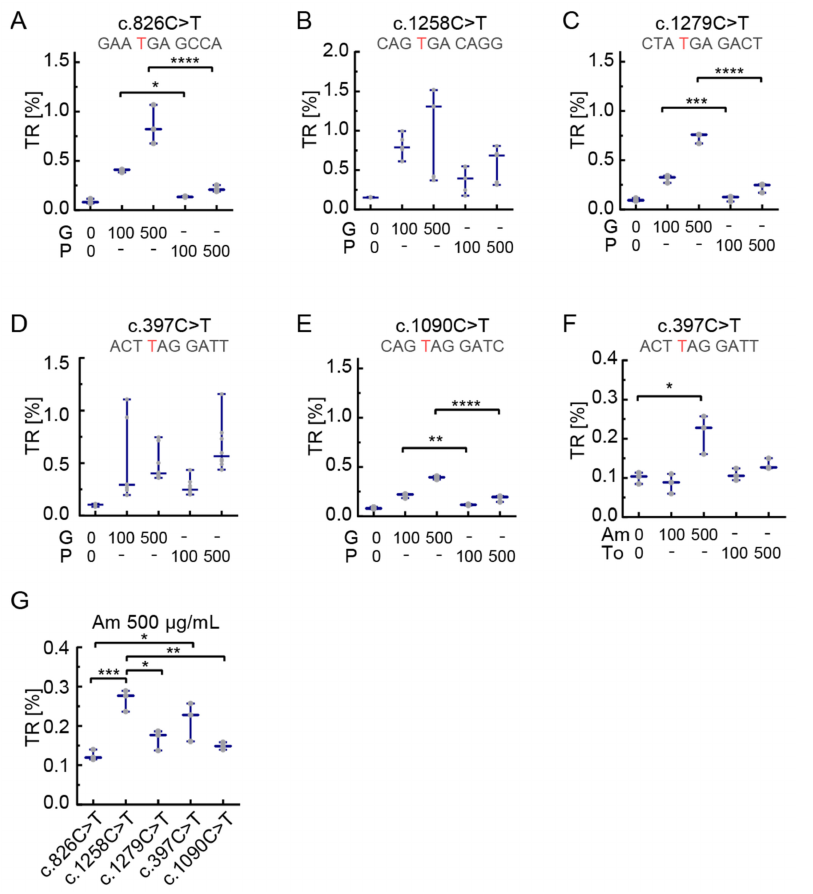
Figure 3. SCC-dependent translational readthrough induction by aminoglycosides. TR induction of gentamicin (G) and paromomycin (P) was analyzed at concentrations of 100 and 500 µ g/mL. ( A – C , E ) Gentamicin leads to higher TR (ns for B) induction than paromomycin in all tested SCCs except c.397C>T. ( D ) In contrast to the other SCCs, paromomycin induces similar TR at c.397C>T as gentamicin. ( F ) Amikacin (Am) at 500 µ g/mL induced significant TR (about 0.25%), while tobramycin (To) did not induce significant levels of TR. ( G ) At 500 µ g/mL, Amikacin induced TR best in c.1258C>T and the c.397C>T SCC. These levels were significantly higher than for the other three SCC. N = 5 ( A , D ); N = 3 ( B , C , E – G ); * p < 0.05, ** p < 0.01, *** p < 0.001, **** p < 0.0001 (Ordinary one-way ANOVA, Tukey’s multiple comparisons test). Concentrations in µ g/mL. The mutated nucleotide resulting in PTC is shown in red.